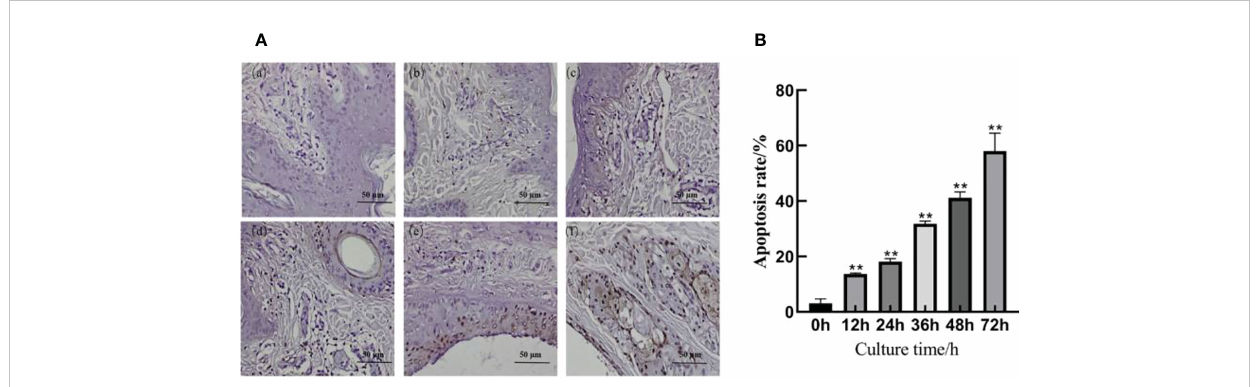
FIGURE 4 Detection of Caspase-3 protein in skin explants infected with F. necrophorum for 72 h. (A) Immunohistochemical images of intertoe skin explants infected with F. necrophorum over 72 h. (A) Skin explants infected with F. necrophorum for 0 h, (B) 12 h, (C) 24 h, (D) 36 h, (E) 48 h, and (F) 72 h. Yellow cells indicate positive expression of Caspase-3 protein by 3, 3 ’ -diaminobenzidine staining. (Scale bar = 50 um). (B) Statistical analysis of the apoptosis rate of skin explants. The data presented are the mean ± SD. *statistical signi fi cance (P < 0.05). **statistical signi fi cance (P < 0.01). The symbols * and ** indicate the signi fi cant differences with the control group.